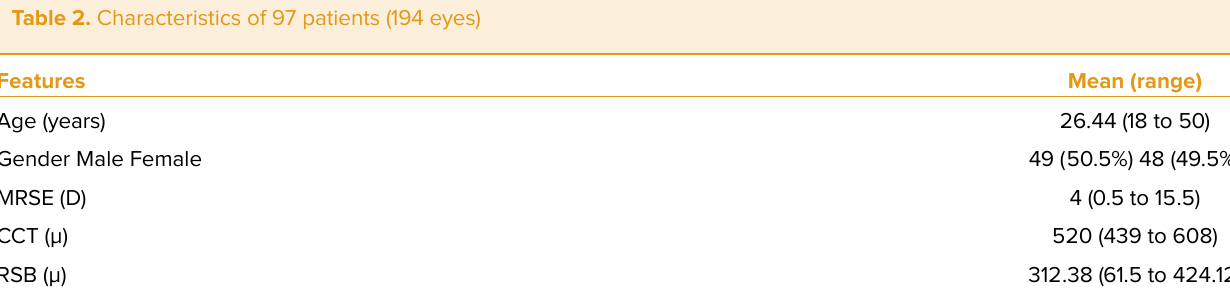
Table 2. Characteristics of 97 patients (194 eyes)